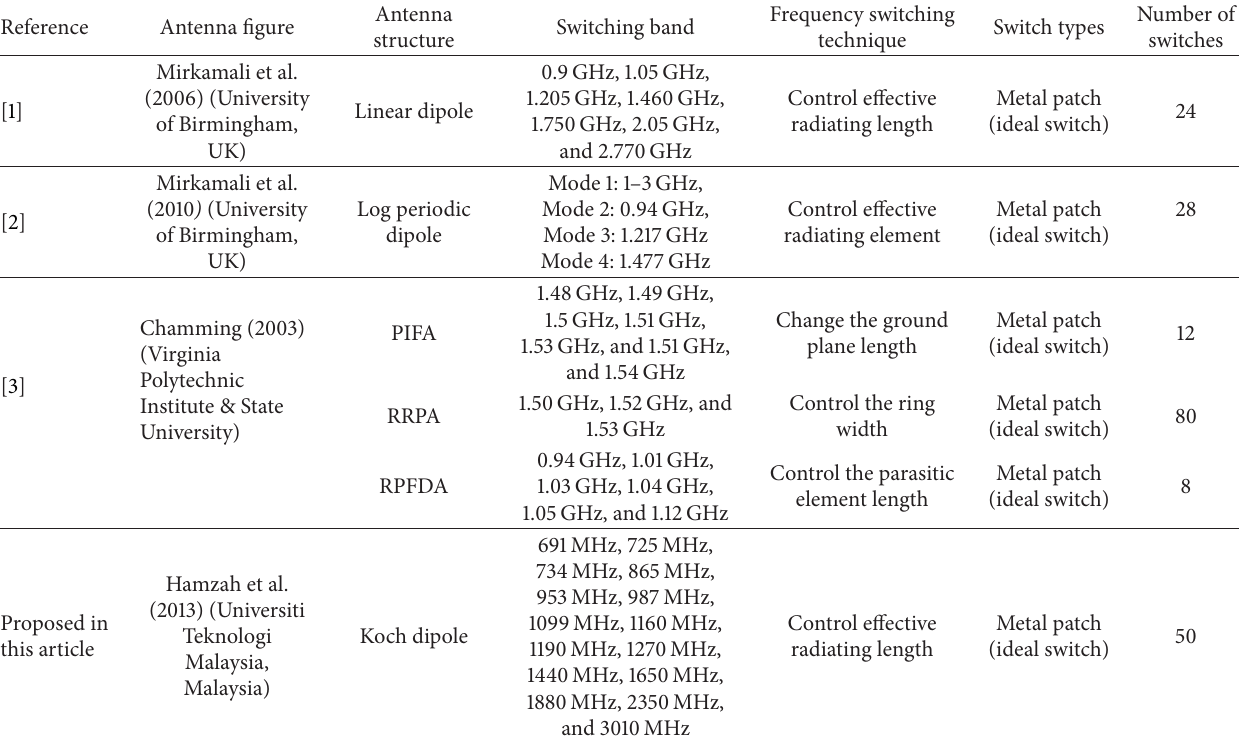
Table 1: Reconfigurable printed antenna with ideal